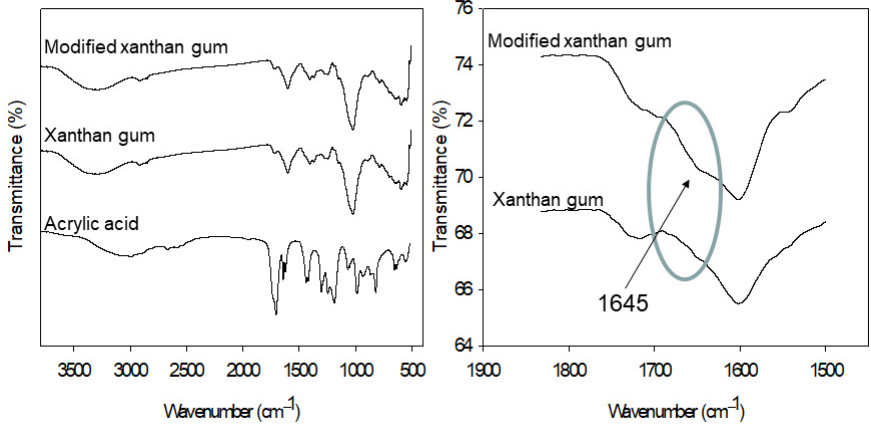
Figure 3. FT-IR spectra of acrylic acid, xanthan gum, and modified xanthan